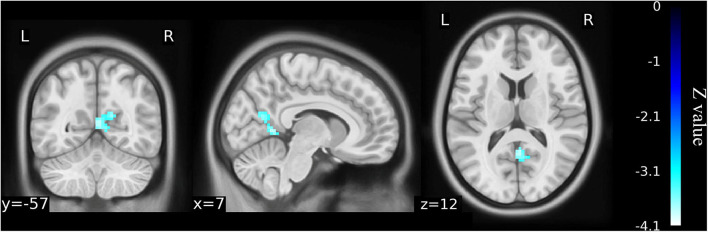
Functional connectivity shows the difference between the postoperative patients (n = 15) and healthy matched controls (n = 23) on the basis of left Cerebelum_9 as the ROI for analysis (voxel-wise p < 0.001 and cluster-wise p < 0.025 for each tail, corrected by GRF). Compared with controls, decreased functional connectivity was identified in left Cerebelum_9 with right precuneus gyrus in the postoperative patients although this was not significantly different from the older KOA patients before surgery. The color bars range from zero to –vmax, which denotes the minimum z-value. KOA, knee osteoarthritis.